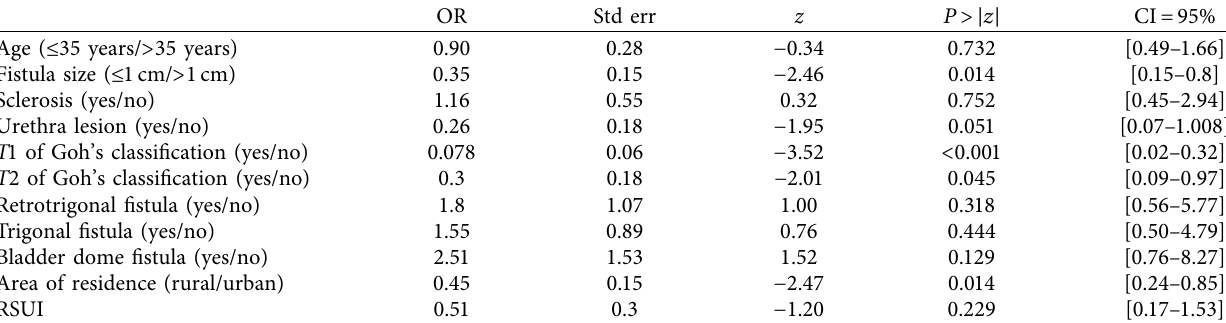
Table 4: Logistic regression model.